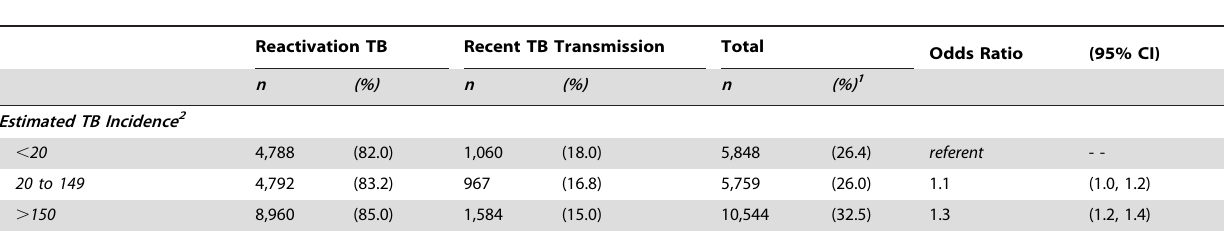
Table 2. Proportion of reactivation TB among foreign-born TB cases by estimated annual TB incidence in the country of origin, United States